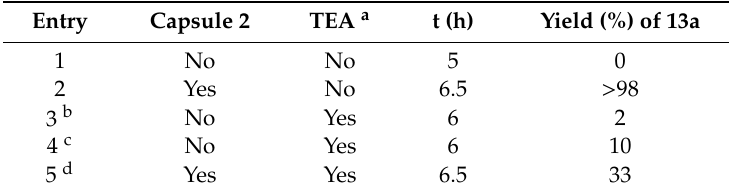
Table 2. Catalysis tests for 1H tetrazole 13a synthesis by reaction of cyclohexyl isonitriles 11a and 12 . Entry Capsule 2